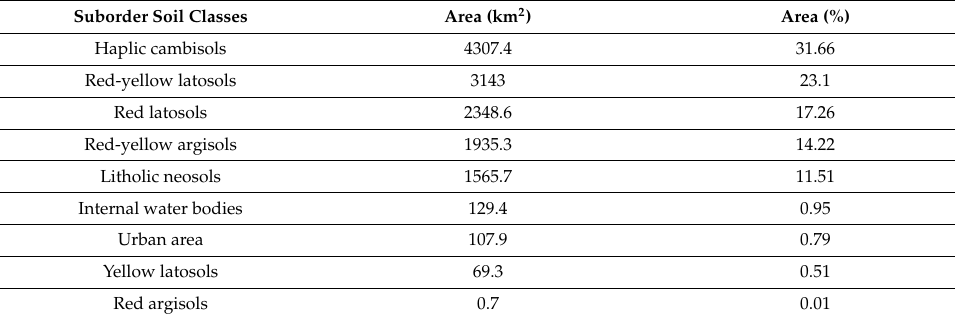
Table 2. Soil Suborder Classes in the Paraopeba River Basin.